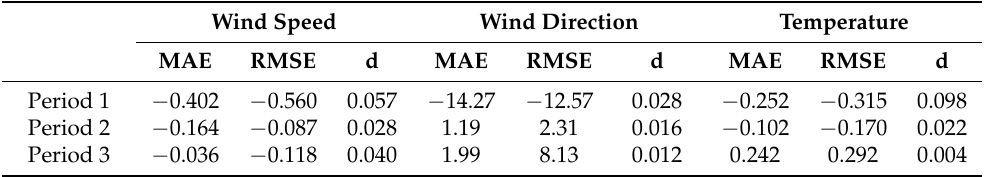
Table 4. The amount of difference of the four statistical indicators’ values between the SPMSver and the